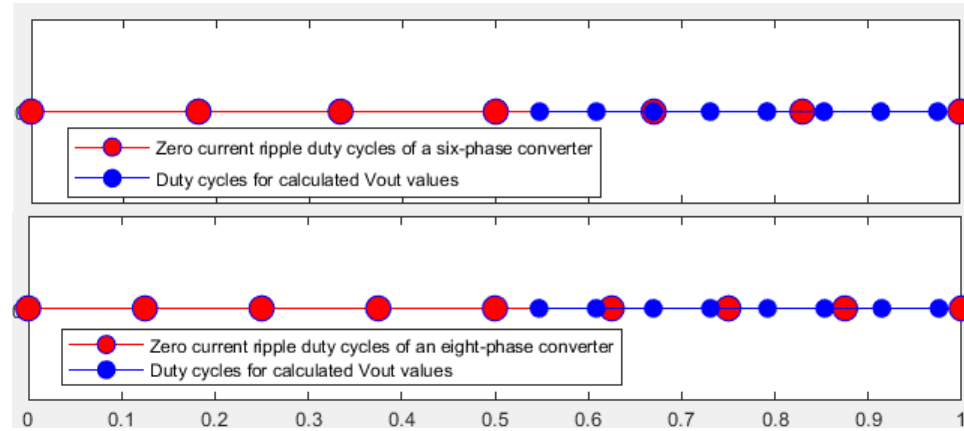
Figure 36. Zero-current ripple duty cycle values of six-phase and eight-phase converters with duty cycle values corresponding to calculated output voltages V out of the converter plotted on the x-axis.